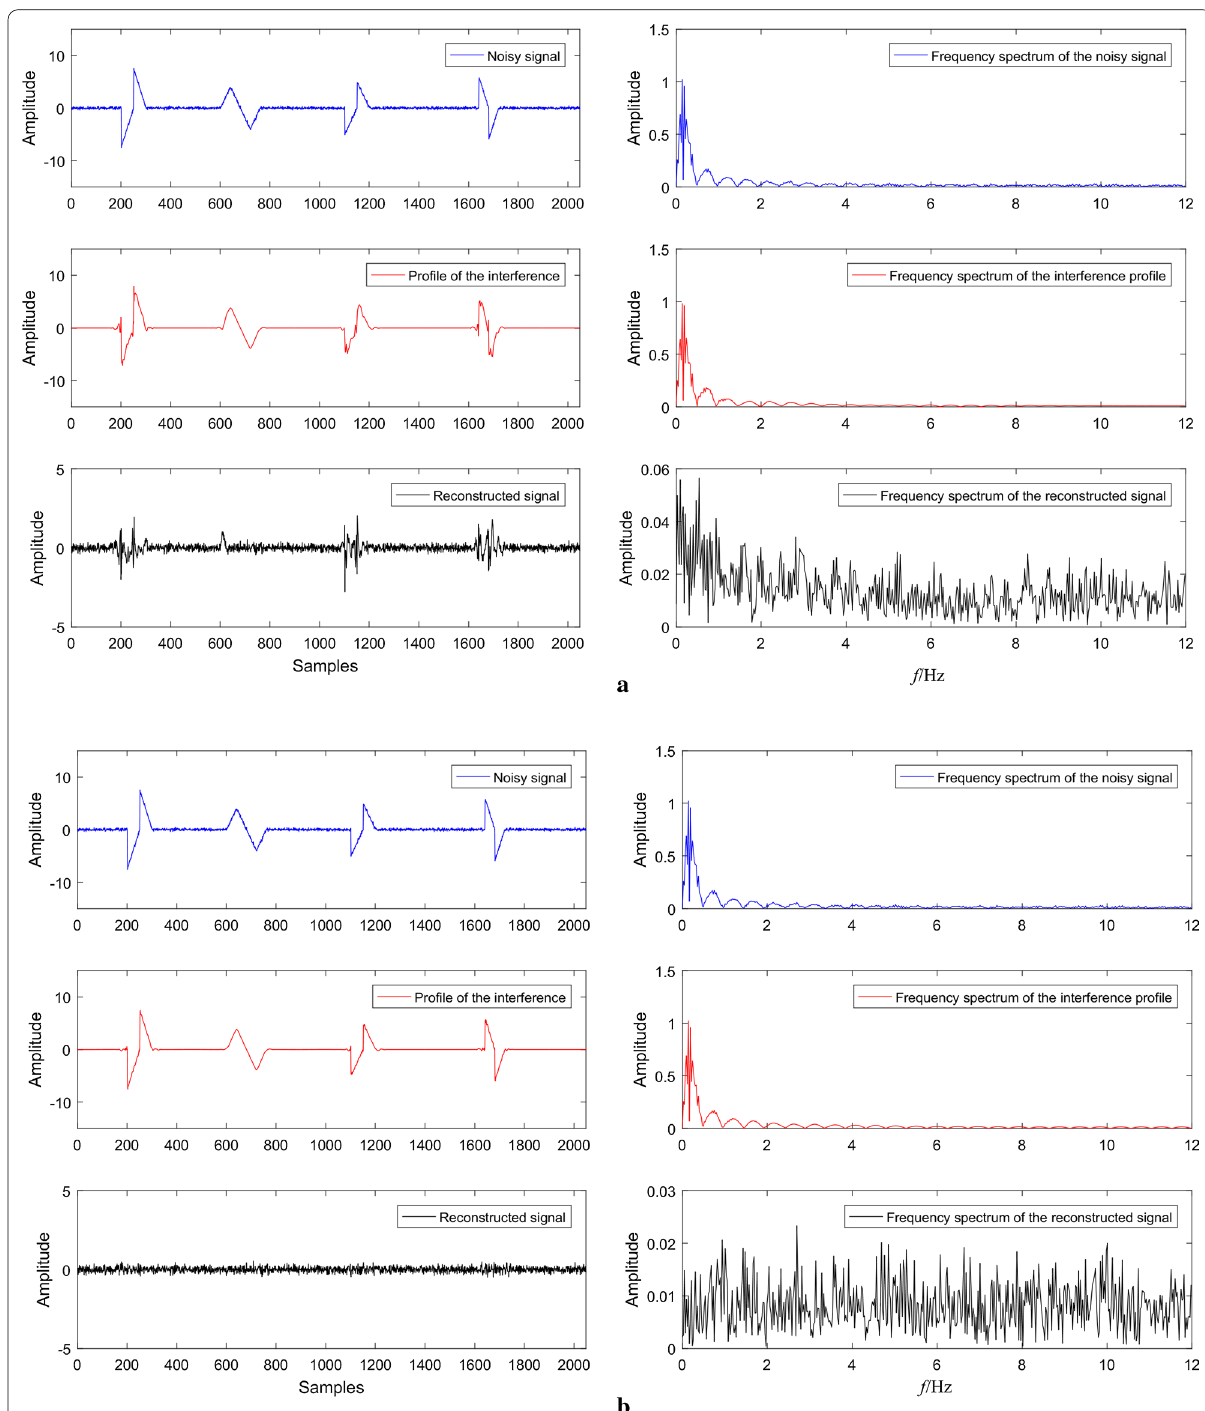
Fig. 2 The denoising effect and frequency spectrum analysis of the noisy signal with a matching pursuit (MP) and b orthogonal matching pursuit